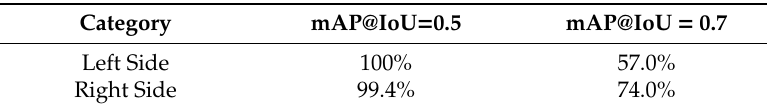
Table 1. Results of condyle detection on AP@0.5,